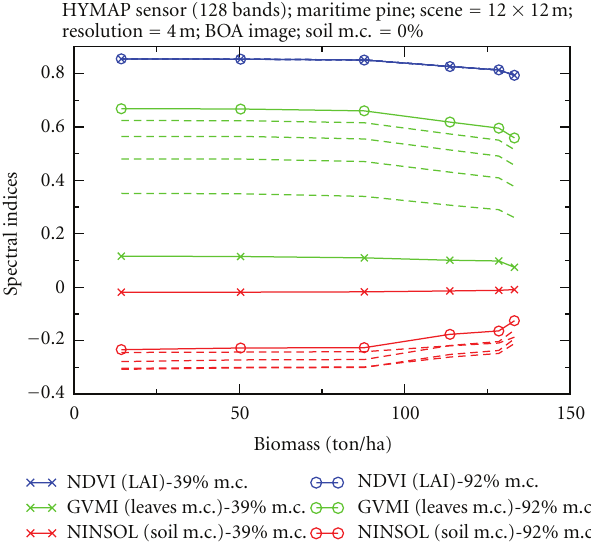
Figure 9: Sensitivity of spectral indices for several biomasses and leaves moisture content.